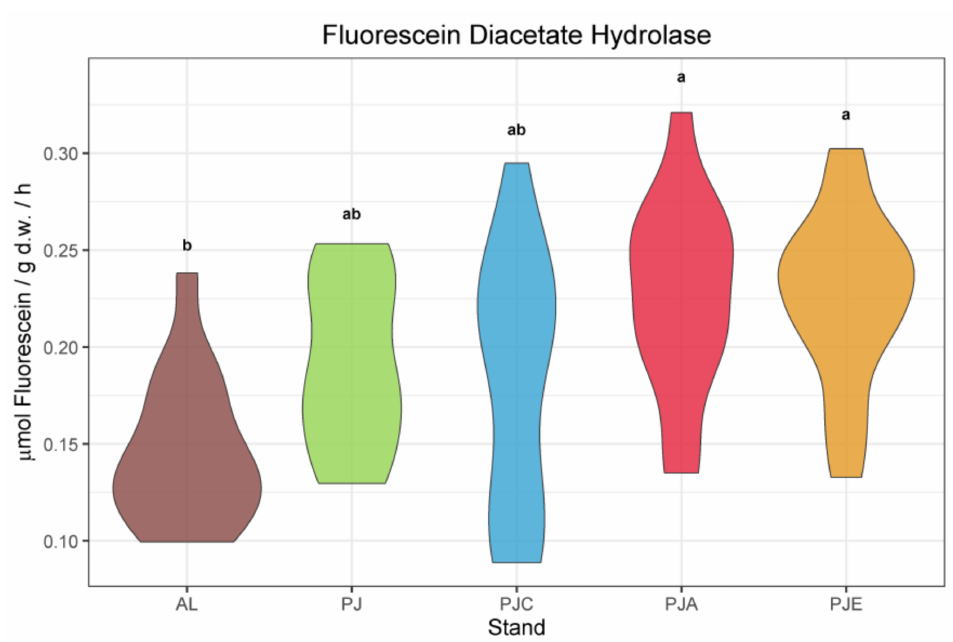
Figure 2. Violin plot of the fluorescein diacetate hydrolase (FDAH) activity in the tree stands and agricultural land plots (see Table 1 for site labels). Different letters indicate significant differences ( p ≤ 0.05, Tukey’s post-hoc test following one-way ANOVA).